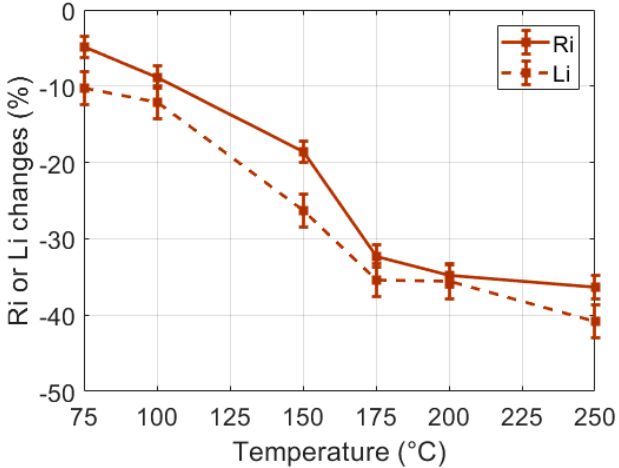
Figure 7. Changes of the dielectric properties of 60 s CHP (30 g) samples versus the heating temperature.